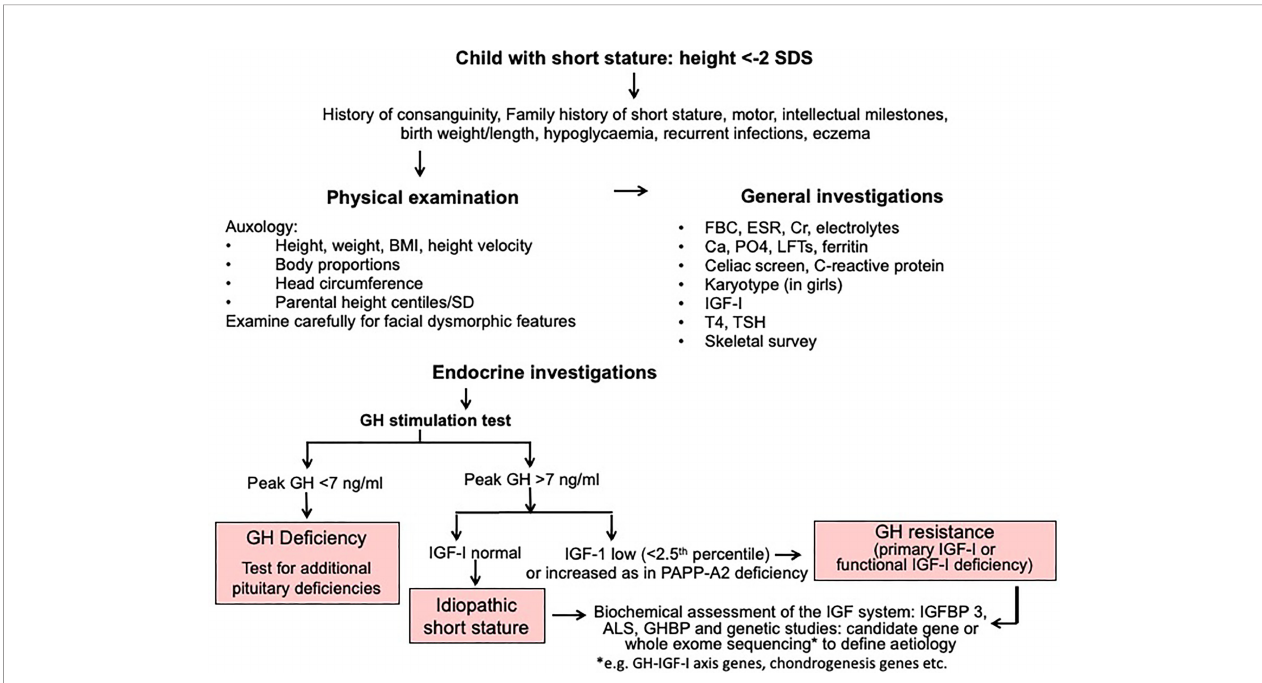
FIGURE 2 | Algorithm for investigation of short stature, idiopathic short stature and GH resistance.